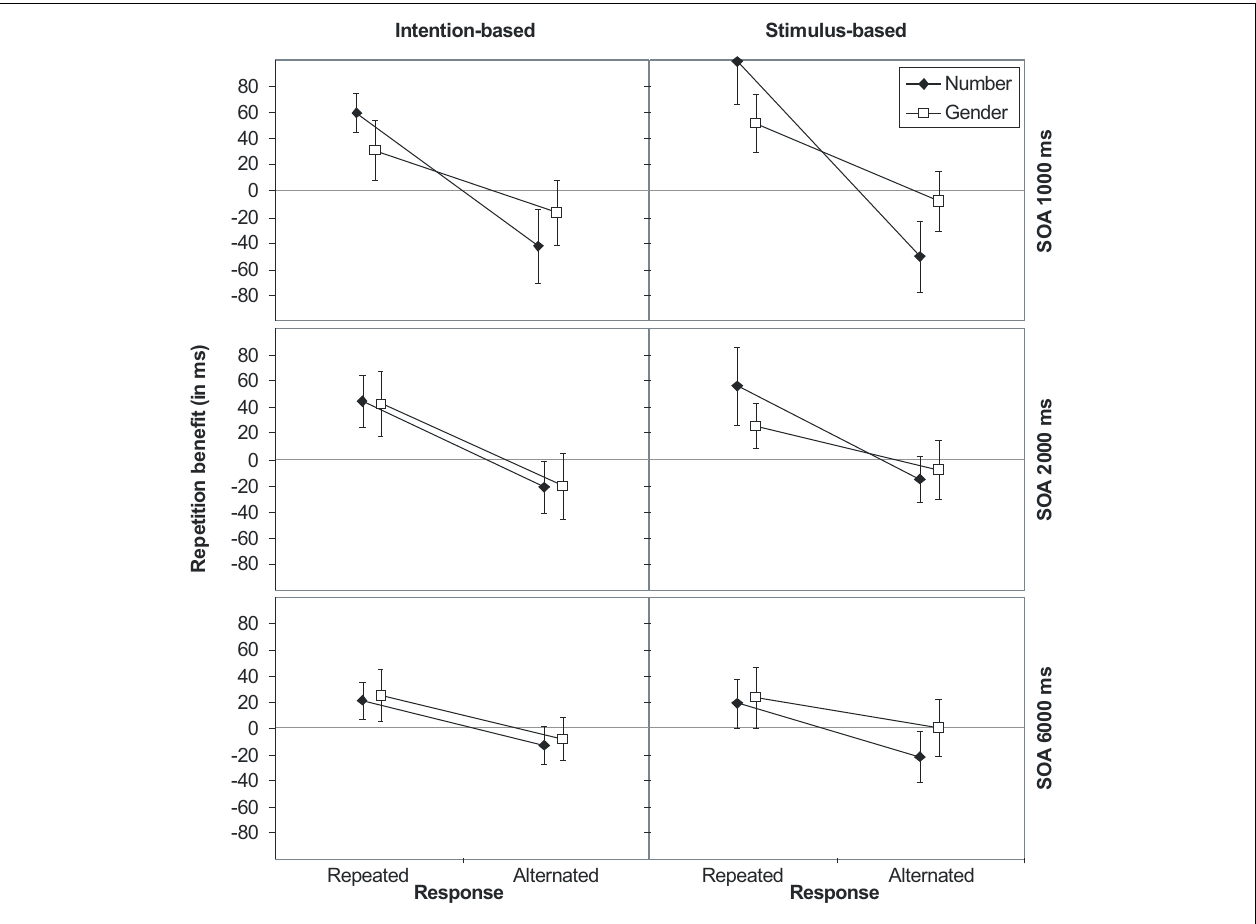
stimulus-onset asynchrony (SOA 1000, 2000, and 6000ms, from top to bottom). Error bars represent the 95% confidence interval of individual means. If error bars do not cross the midline, the repetition benefit (or cost) is significantly different from zero ( p <